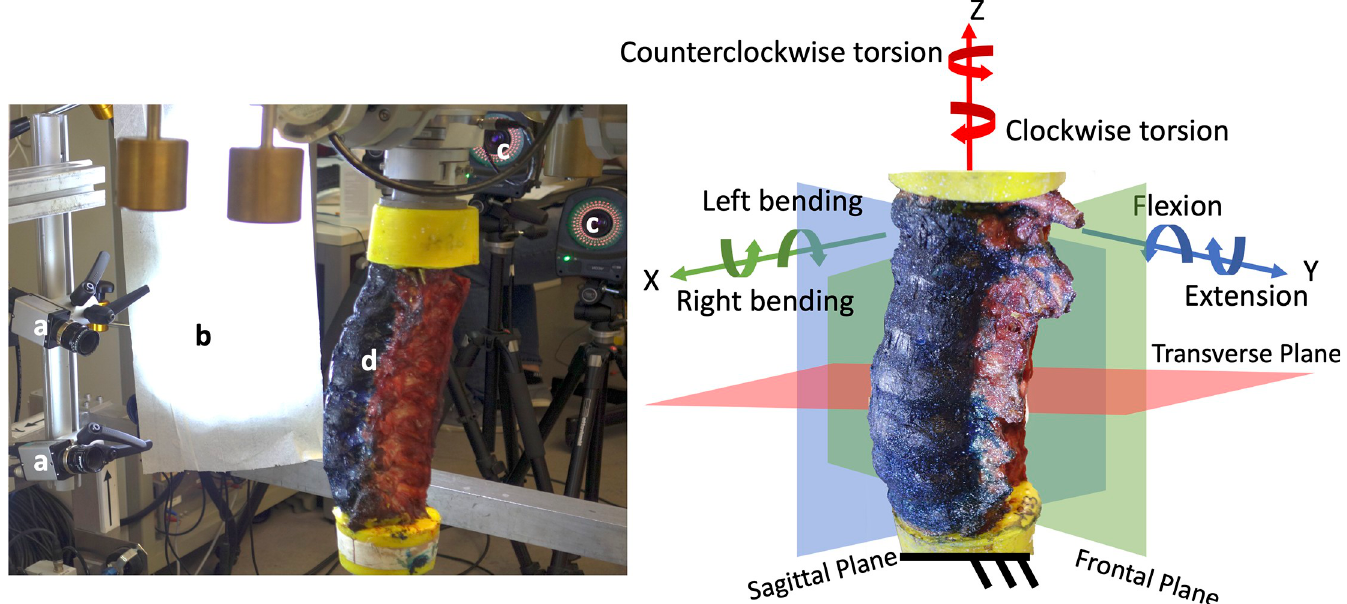
Fig 1. Left: overview of the testing setup showing (a) the DIC cameras, (b) the DIC light system, (c) the optoelectronic cameras and (d) the specimen. Right: detail of the spine segment. The white-on-black pattern is visible. Also shown is the three-dimensional coordinate system used by the different measurement tools: the transverse plane of the spine segment corresponds to the xy-plane of the coordinate system, the sagittal plane to the xz-plane and the frontal plane to the yz-plane. The X-axis is forward, the Y-axis left and the Z-axis cranial.